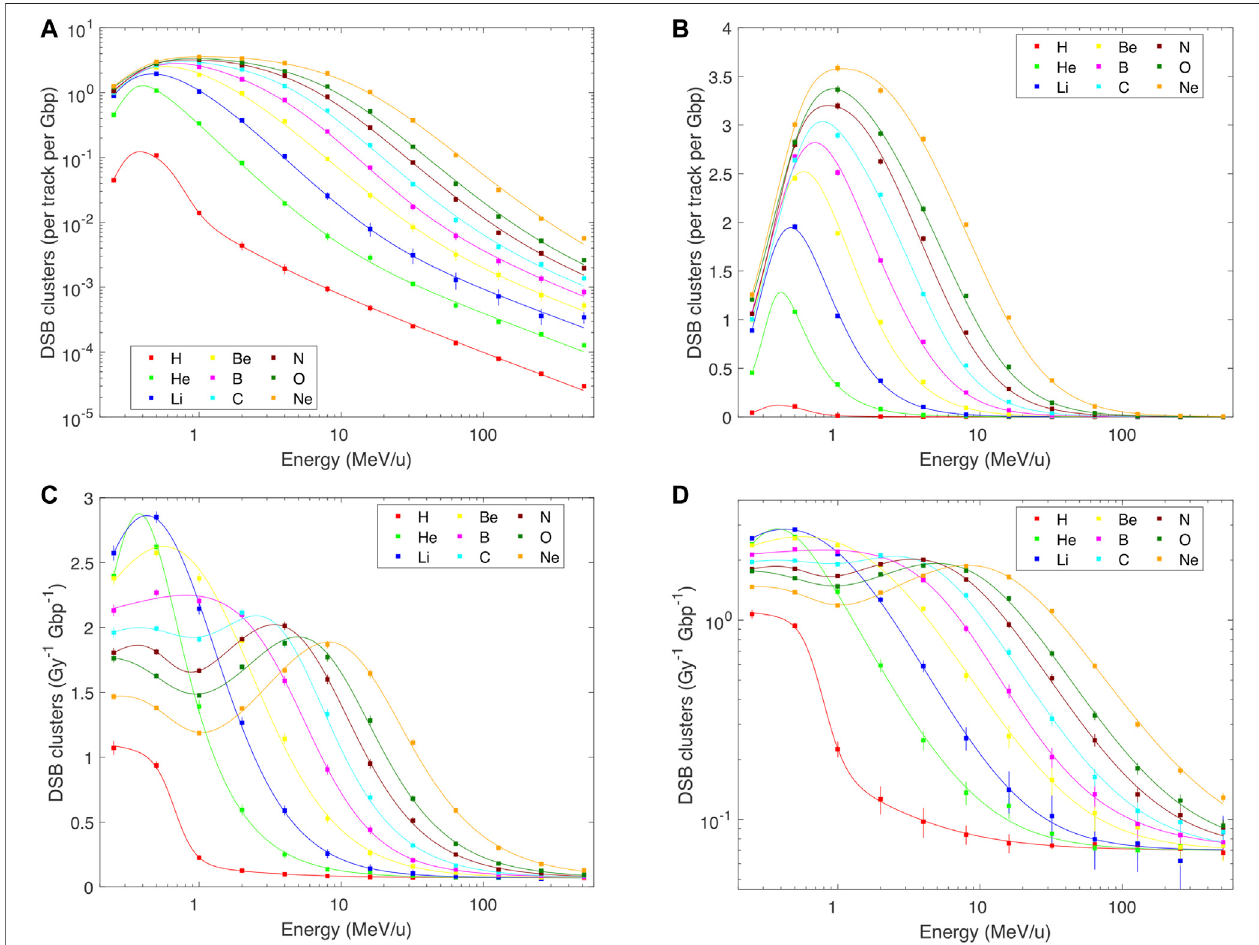
FIGURE 3 | PARTRAC simulations (symbols) and their fi ts by analytical formulas (lines) for the yields of DNA double-strand break clusters (DSB clusters) in human lymphocytes by H – Ne ions with starting energies from 0.25 to 512 MeV/u. Error bars depict estimated 95% con fi dence intervals of the simulated results. Where error bars are not visible, they are smaller than the symbols. Panels (A,B) : yields per track per Gbp, in logarithmic and linear scales, calculated as a product of Eqs 1 and 2 , details in the text; panels (C,D) : yield per Gy per Gbp, in linear and logarithmic scales, fi tted by Eq. 2 with parameters in Table 2 .